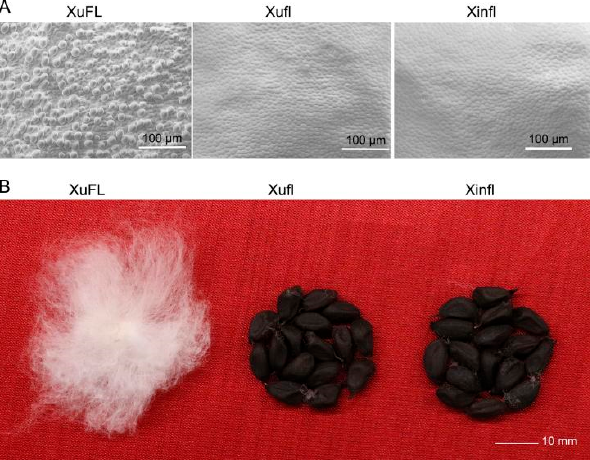
Figure 1. The phenotype of XuFL, Xufl , and Xinfl . ( A ) The scanning electron microscope images of 0-DPA ovules of XuFL, Xufl , and Xinfl . ( B ) The mature fibers and seeds of XuFL, Xufl , and Xinfl . XuFL, wild-type Xuzhou 142; Xufl , Xuzhou 142 lintless-fuzzless mutant ; Xinfl , Xinxiangxiaoji lintless-fuzzless mutant .